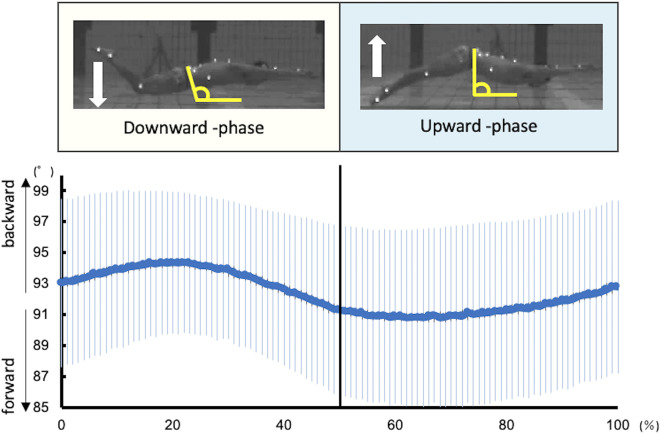
Kinematic data of the pelvic tilt angle during UUS. The angle of the pelvis was defined as the angle between the line connecting the ASIS and PSIS and the horizontal line. The larger the angle, the more backward is the pelvis, and the smaller the angle, the more forward it is.